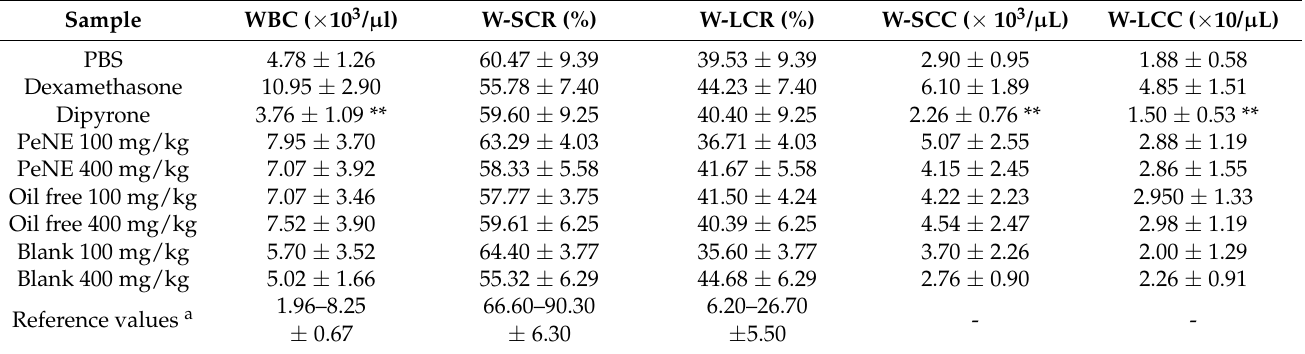
Table 5. Leukogram analyses in male Wistar rats after oral treatment with PeNE or free pequi oil for 15 days.